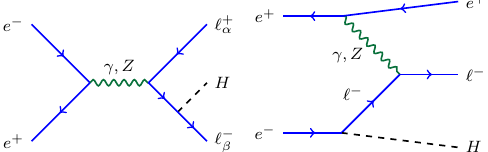
Figure 1. Representative Feynman diagrams for on-shell production of H at future lepton colliders via the process in Equation (2). Figure from Ref.